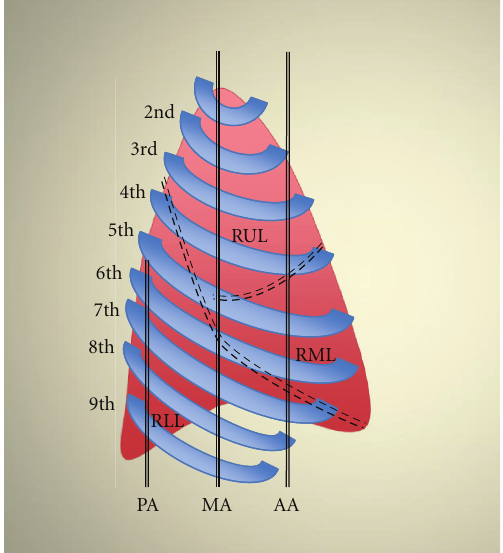
Figure 2: Lateral view of the right lung. Schematic representation of pulmonary lobes in relation to ribs and intercostal spaces along anterior axillary (AA), midaxillary (MD), and posterior axillary (PA) lines,